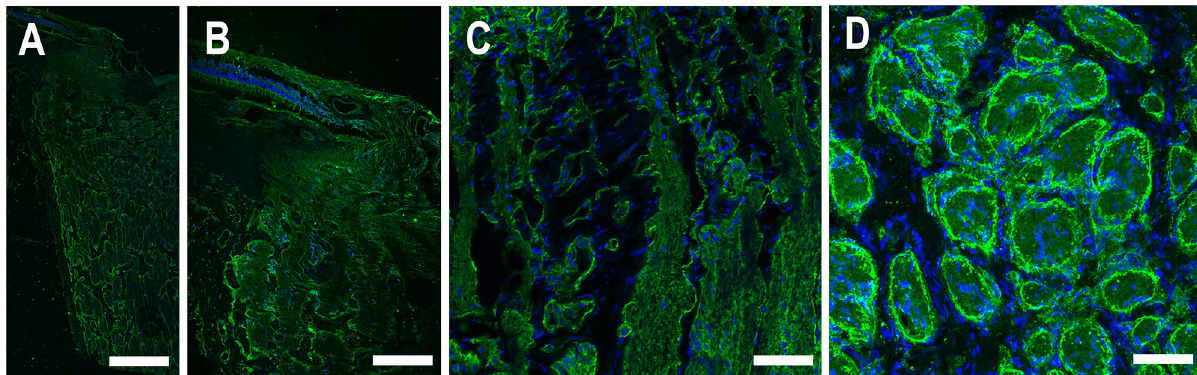
Fig 5. Labeling for α -dystroglycan ( α DG, green) in human (A, B) and porcine (C, D) optic nerve head region in longitudinal sections (A, B, C) and cross-section (D). α DG is present throughout the retina, pre-lamina, lamina, and myelinated nerve. It is more evident in the periphery of axon bundles, basement membrane and bordering blood vessels. DAPI (blue). Scale Bar: 200 μ m (A), 50 μ m (B), 25 μ m (C, D).